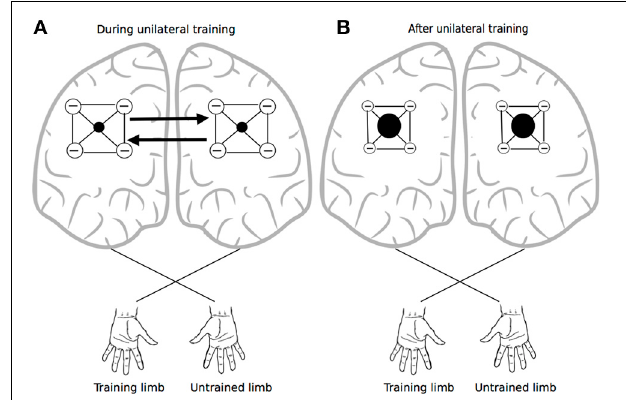
FIGURE 2 | Crossed reciprocal surround inhibition. The black filled circles represent excitatory nodes within intracortical circuits (i.e., in both hemispheres) that project to the focal muscles engaged by the training task. These are surrounded by a more extensive inhibitory zone. Following Bianki (e.g., Bianki and Makarova, 1980; Bianki and Shrammapril, 1985), Panel (A) represents interactions that occur during unilateral training.